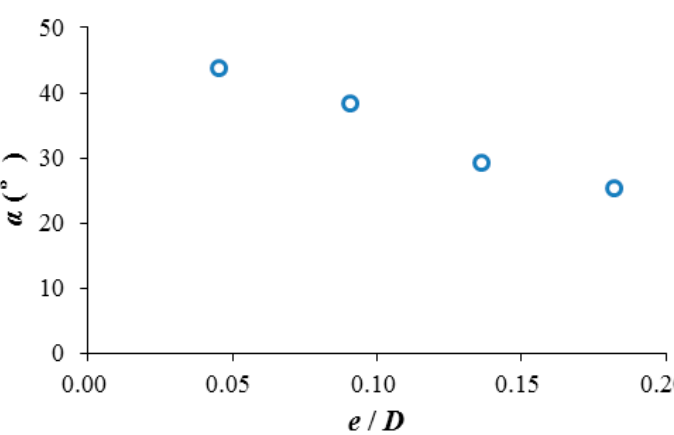
Figure 7. Variation of scour front angle with pipeline embedment.